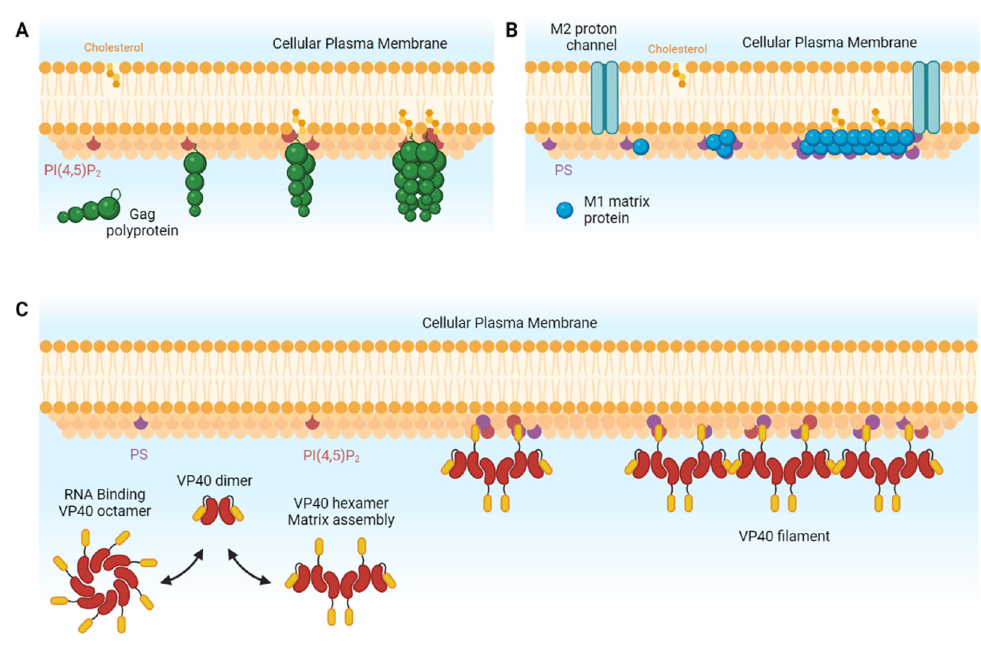
Figure 1 . Molecular steps of virus assembly at the plasma membrane. ( A ) HIV ‐ 1 Gag binds to the membrane via its myristoyl segment insertion and interacts mainly with negatively charged lipids PI(4,5)P 2 via the HBR region of its MA domain to form lipid domains enriched in PI(4,5)P 2 and cholesterol. ( B ) IAV M1 interacts with negatively charged PS and clusters cholesterol to form lipid domains. The multimerization was also proposed to be initiated at the location of the M2 transmembrane ion channel. ( C ) EBOV VP40 dimers existing in solution either reorganize in octamers to bind RNA or multimerize in hexamers, which elongate in filaments during assembly.